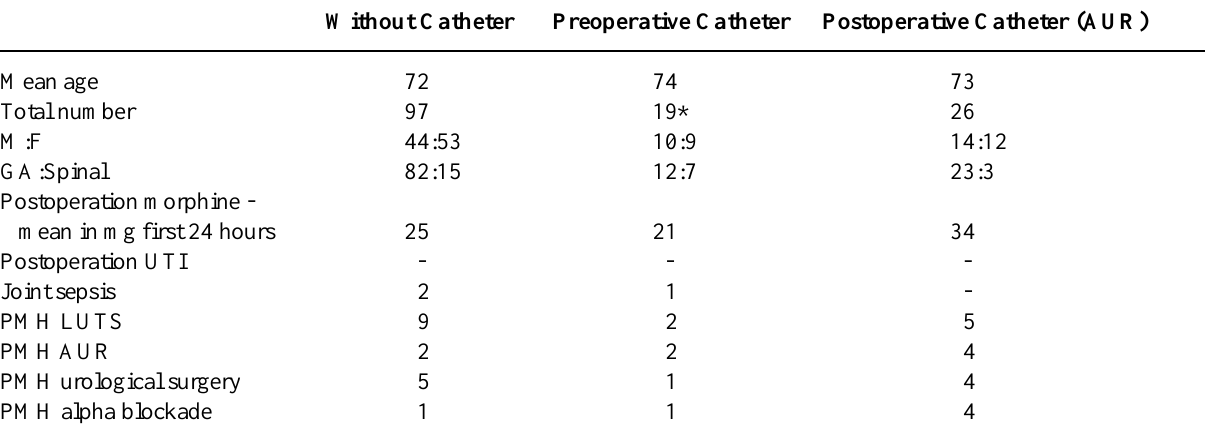
Table 1 – Demographics for all 142 patients divided into 3 groups: without catheter, preoperative catheter and postoperative catheter for acute urinary retention